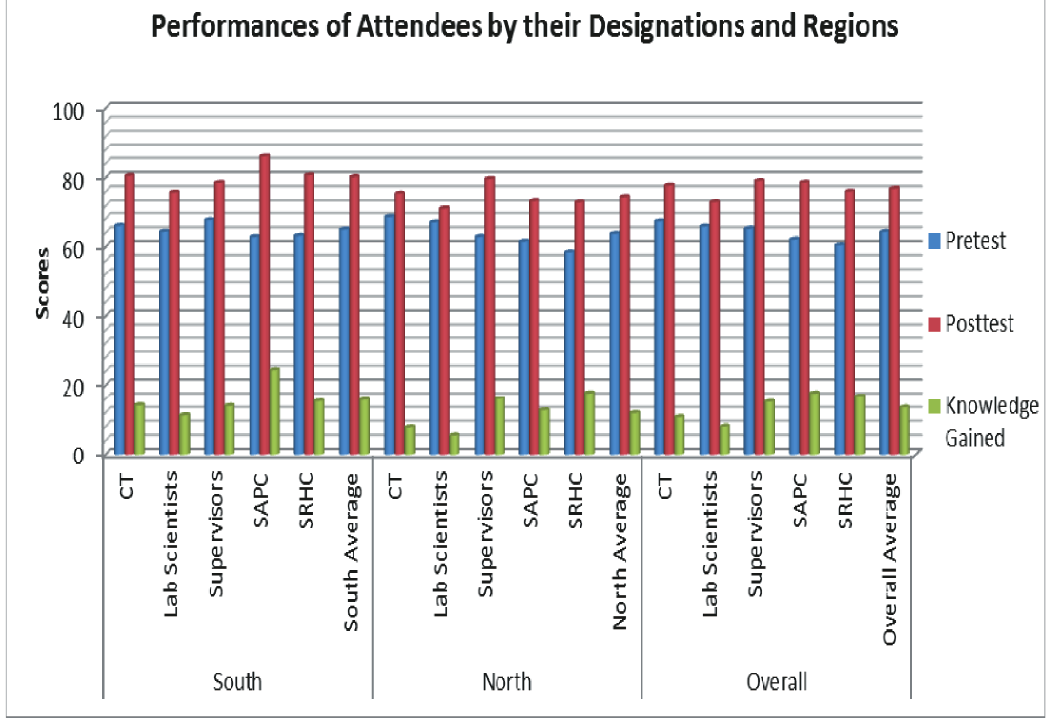
Figure 2. Performance of attendees by their designations and regions